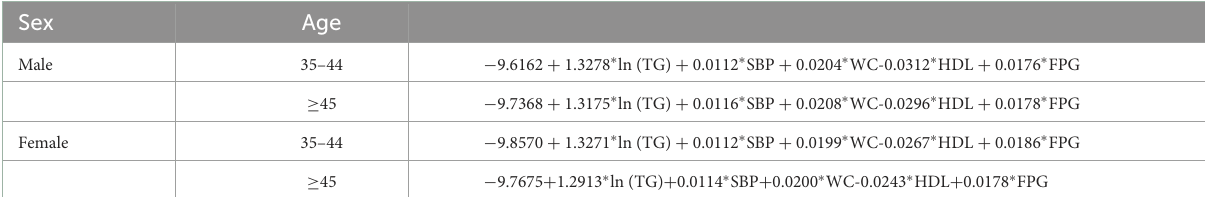
GFI,goodnessoffitindex;SRMR,standardizedrootmeansquareresidual;AGFI,adjustedgoodnessoffitindex;MFI,McDonaldfitindex;CFI,comparativefitindex;NFI,normedfitindex; RMSEA,rootmeanssquarederrorofapproximation;WC,waistcircumference;SBP,systolicbloodpressure;HDL,high-densitylipoprotein;FPG,fastingplasmaglucose;TG,triglyceride.